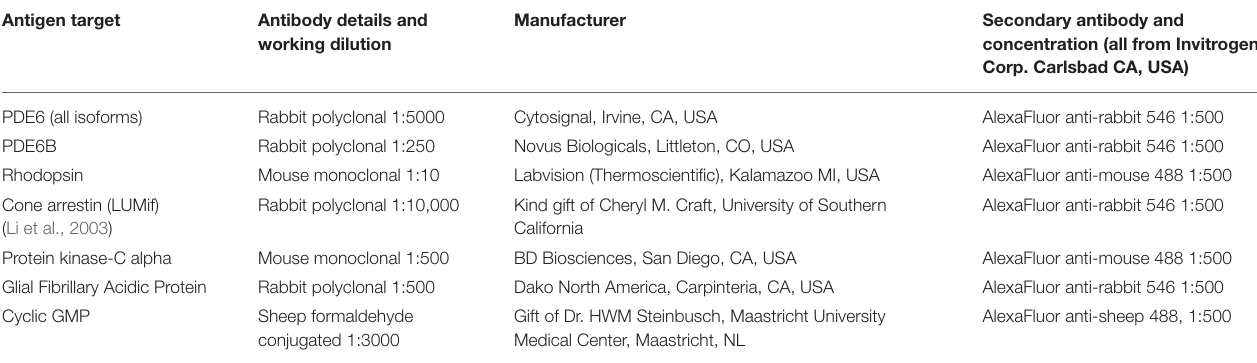
TABLE 2 | Primary antibodies used for